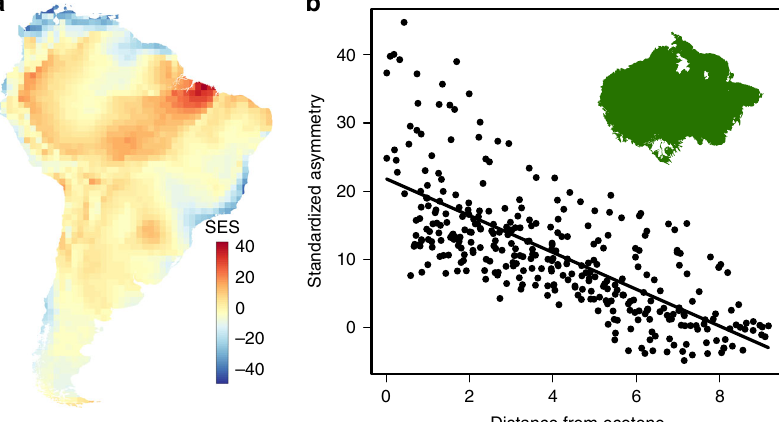
Fig. 4 Null model divergence of ADF vector symmetry. a The deviation of the ADF symmetry vectors of birds from the null model (Supplementary Fig. 7), calculated as the standardized effect size (SES) deviation of vector lengths after 1000 repetitions of the null model. b The relationship between the deviation from the null model and the distance from the ecoregion boundary for the subset of grid cells ( n = 342) that are completely encompassed within Amazonia (Supplementary Fig. 9; R 2 = 0.52). The least square regression explains 52% of the